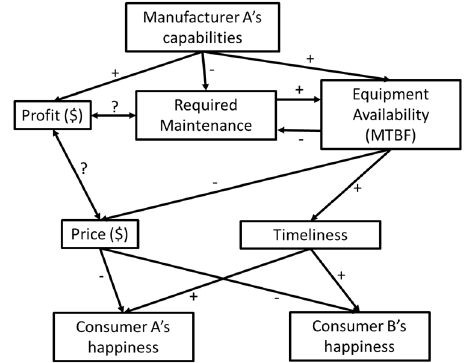
Figure 6. Cognitive map from consumer’s perspective